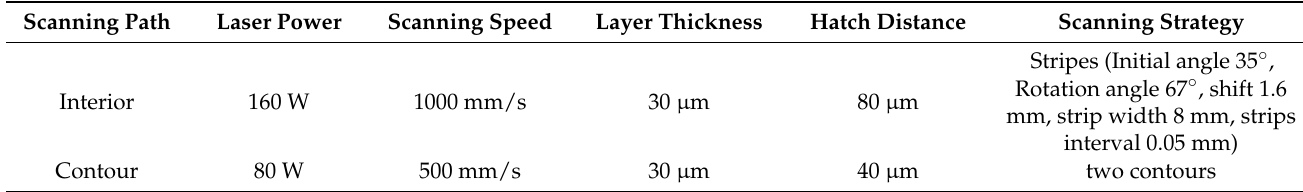
Table 1. Parameters of selective laser melting (SLM) processed (built) samples.